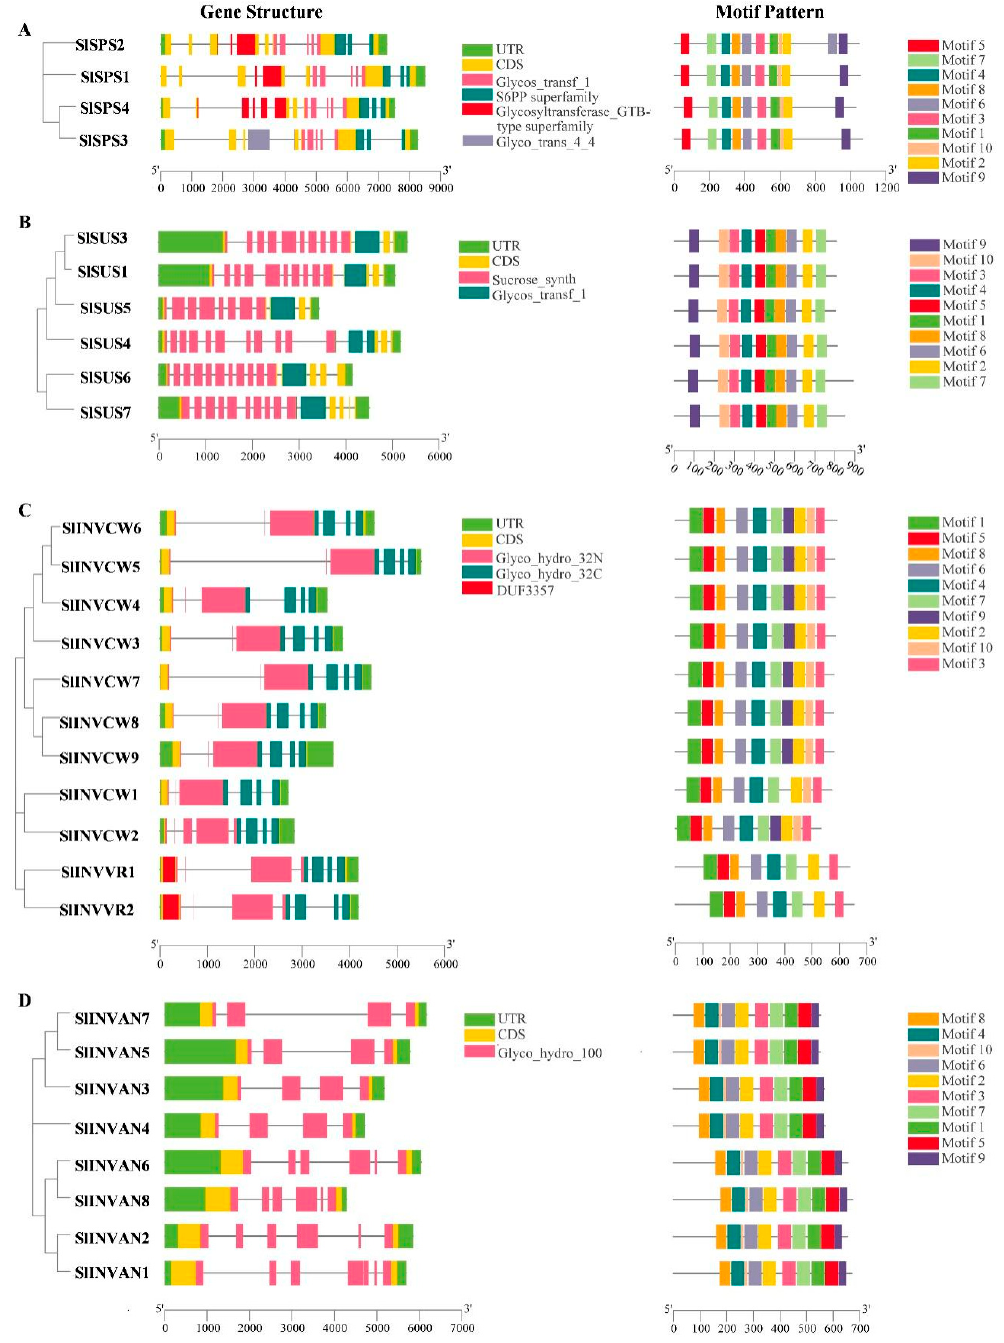
Figure 2. Gene structure and conserved motif analysis of SPS ( A ), SUS ( B ), acid INV ( C ) and alkaline/neutral INV ( D ) in tomato. In the gene structure, the filled boxes and lines represent exons and introns, respectively. The green and yellow boxes, respectively, represent UTR sequence and CDS. In the motif map, different conserved motifs were shown in different